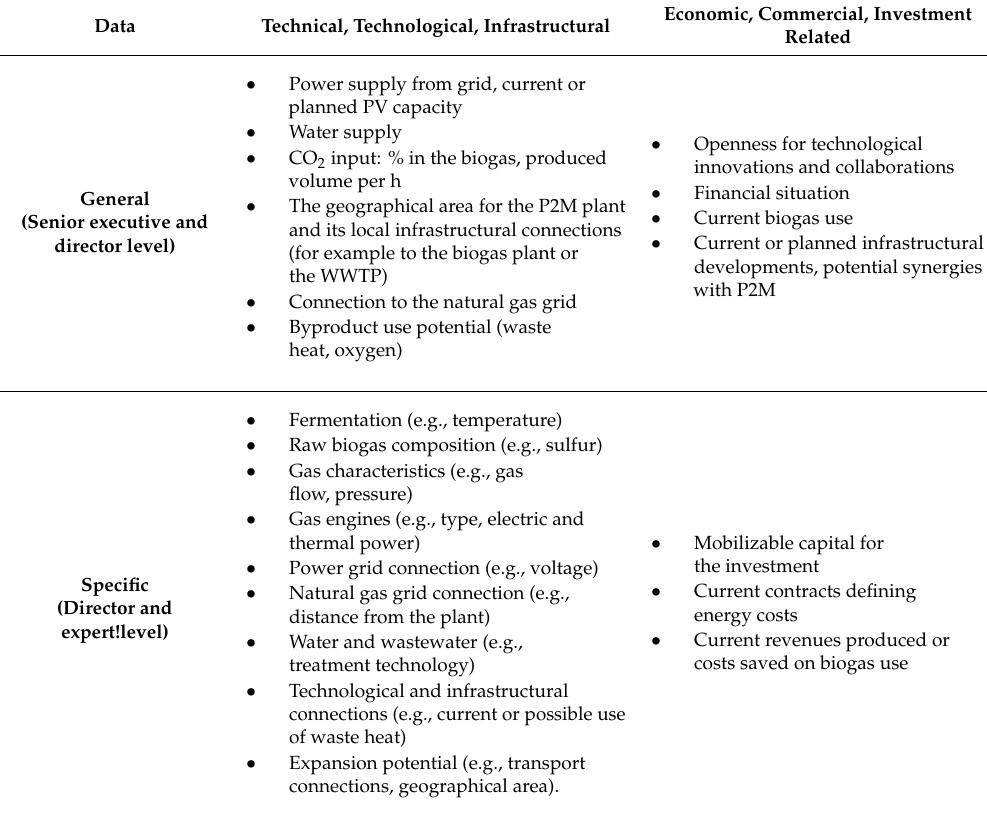
Table 1. Structure of data